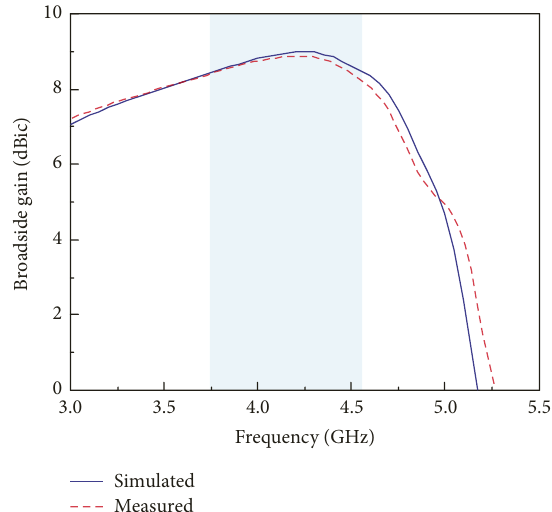
Figure 13: Simulated and measured broadside gain of the antenna.